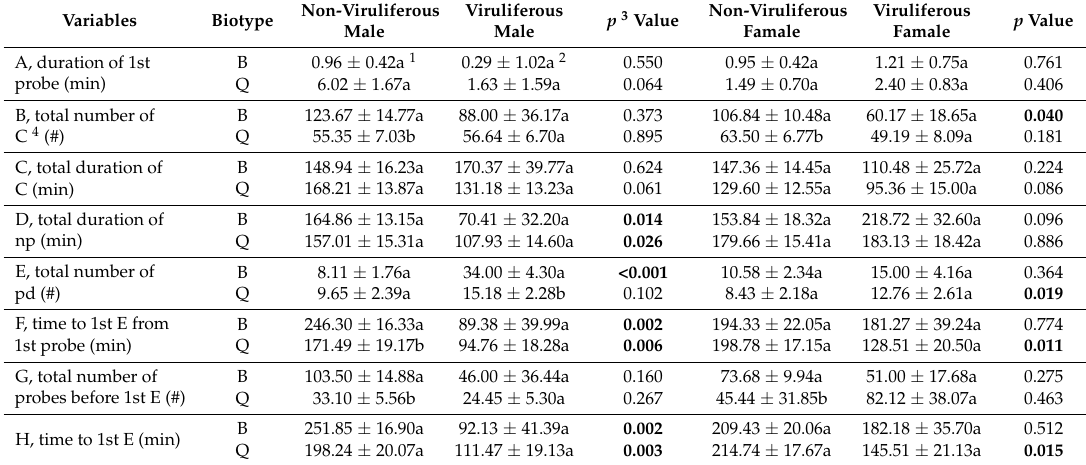
Table 1. EPG non-phloem variables of different sexes of non-viruliferous and viruliferous B. tabaci B and Q